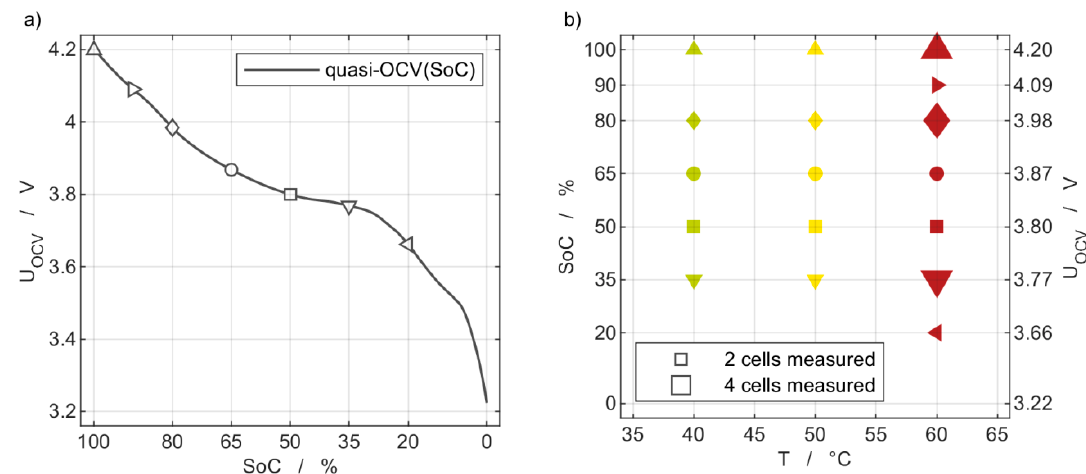
Figure 1. ( a ) OCV characteristic at 25 °C and BoL state with indicated SoC levels of the conducted storage tests. ( b ) Design of experiment matrix for the aging tests, including the corresponding number of cells investigated at the specific storage conditions.